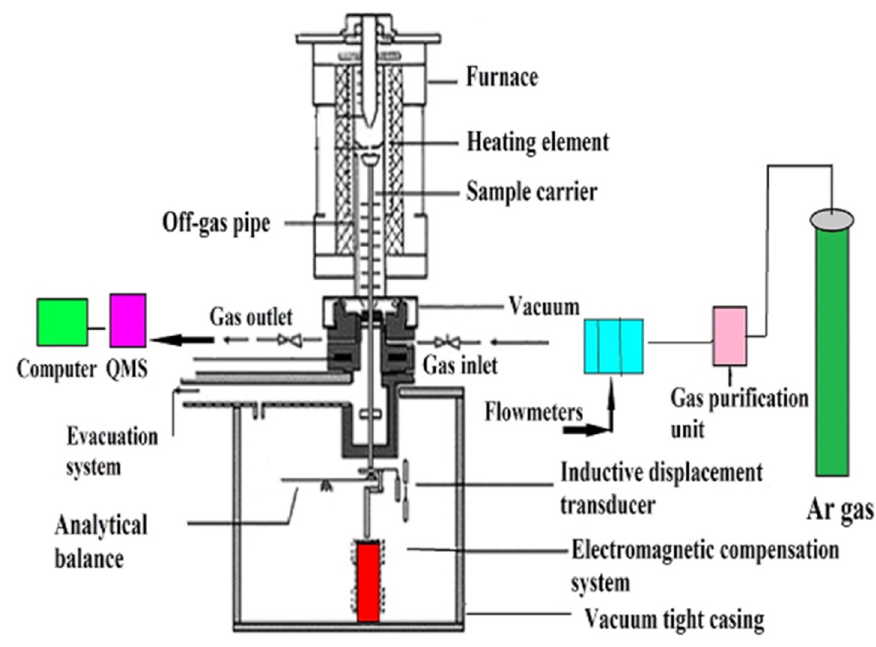
Figure 5. Schematic diagram of TGA/QMS (thermogravimetry/quadruple mass spectroscopy) system.